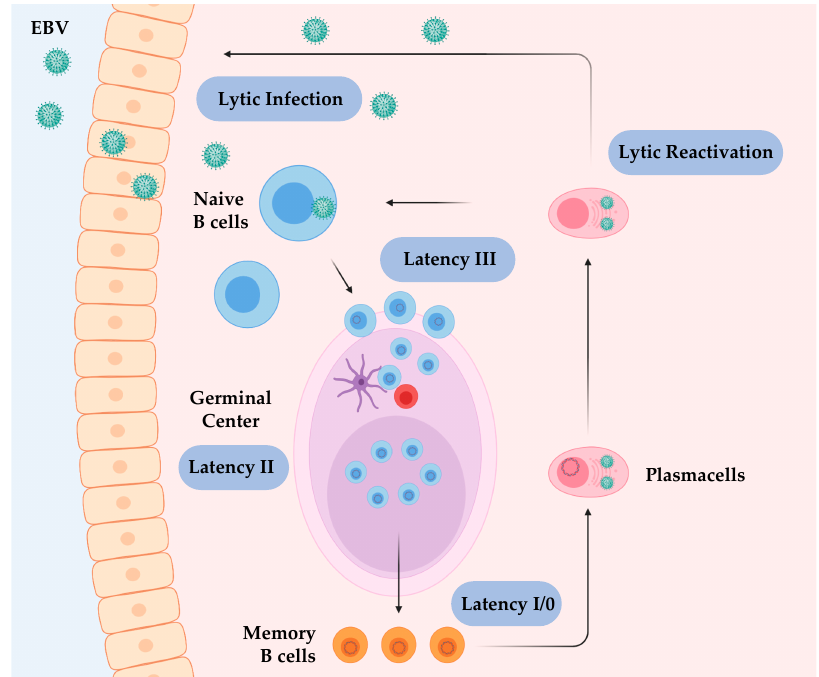
Figure 1. Epstein–Barr Virus (EBV) life cycle and latency stages. The viral life cycle includes at least five different stages (Lytic infection, Latency III, Latency II, Latency I/0, and Lytic reactivation), and four of them are associated with EBV diseases. EBV infects submucosal B cells, inducing viral gene transcript expression that establishes the latency III program. The infected cells pass through the lymph node germinal centre, proliferate and mature. During this stage, EBV induces gene expression of the Latency II program. Some latently infected memory B cells leave the germinal centre and persist (Latency I/0), whereas occasionally some infected memory cells evolve to plasma cells that shed newly assembled free virions into saliva (lytic reactivation). Credits: Created with BioRender.com.